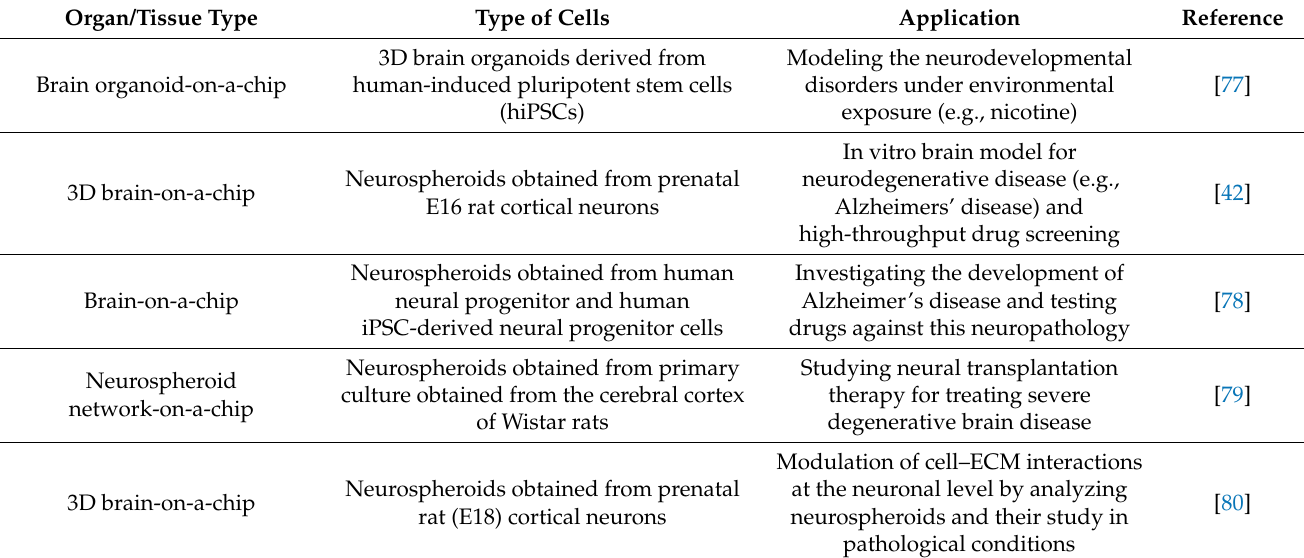
Table 3. PDMS microfluidicbrain-on-a-chip